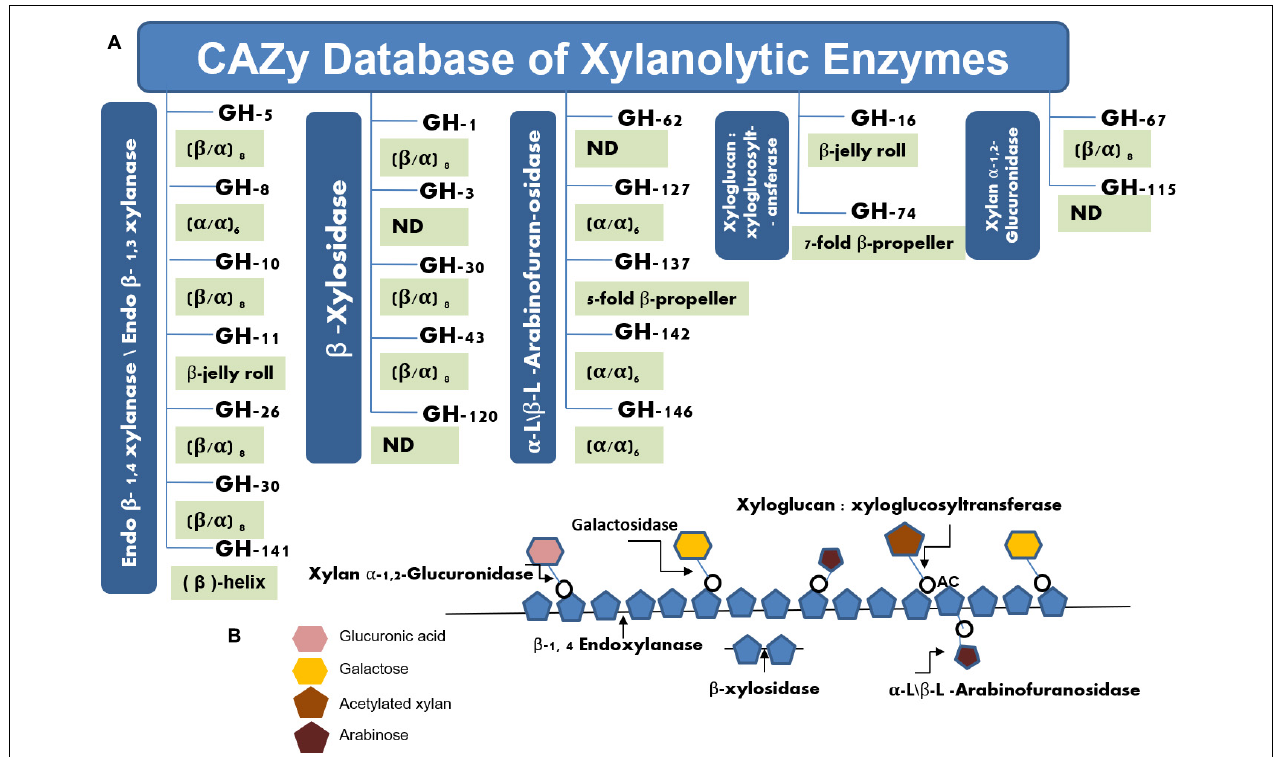
FIGURE 1 | Pictorial representation of various glycosyl hydrolases families having xylan hydrolytic enzymes (A) . Schematic representation of various xylanolytic enzymes for their activity toward heterogeneous xylan (B)